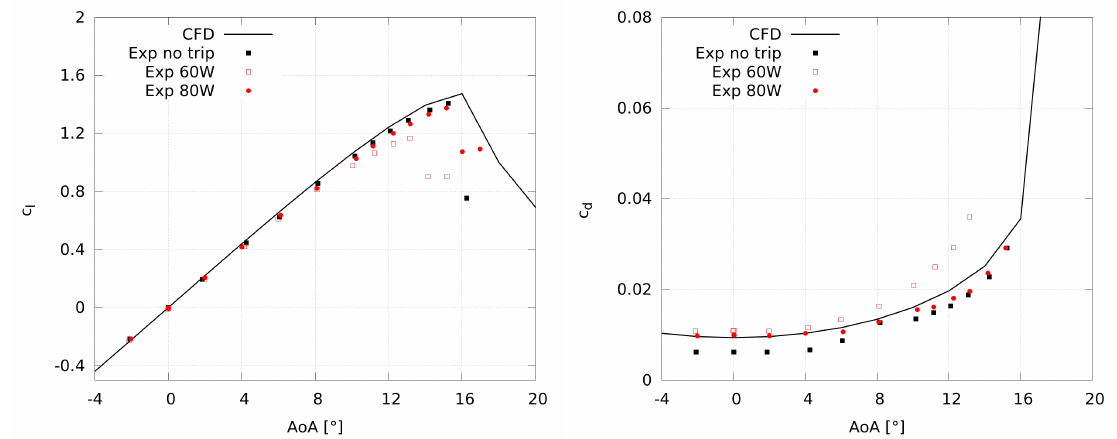
Figure A1. Validation of lift and drag coefficients of a NACA 0012 at Re = 2 × 10 6 (experimental results by Ladson [41]).